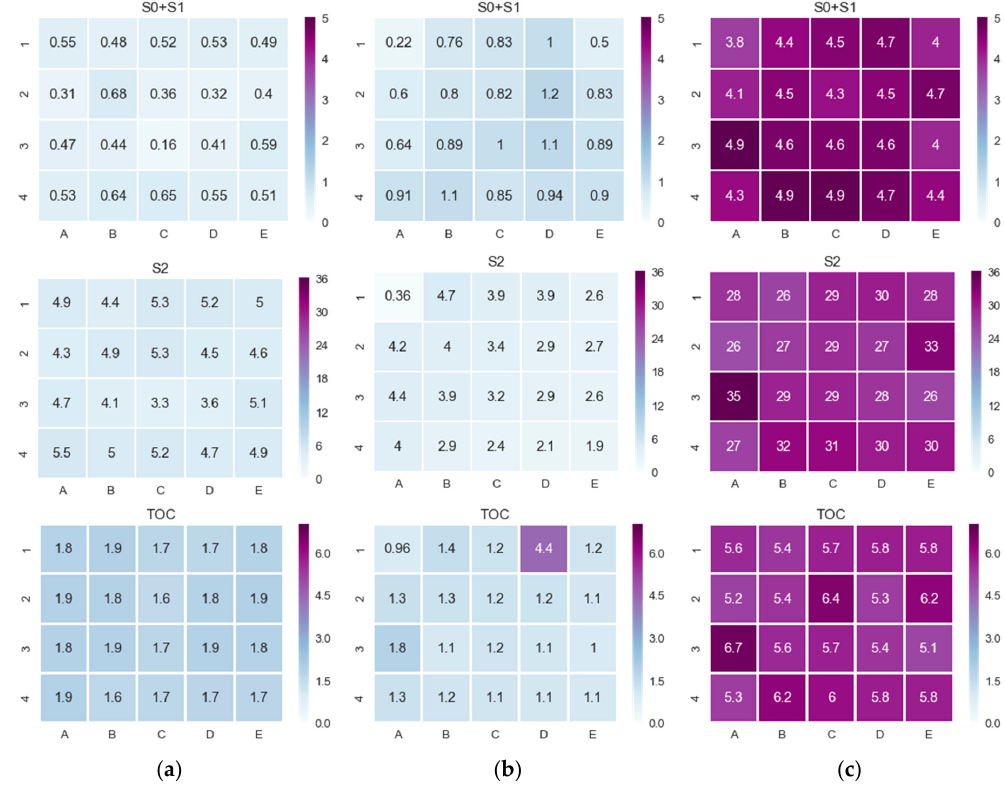
Figure 12. Distributions of S0 + S1 (evaporated hydrocarbons content, mg HC / g rock), S2 (HC products of kerogen decomposition content, mg HC / g rock), and TOC (%wt.) after thermal exposure in samples ( a ) #10; ( b ) #12. ( c )